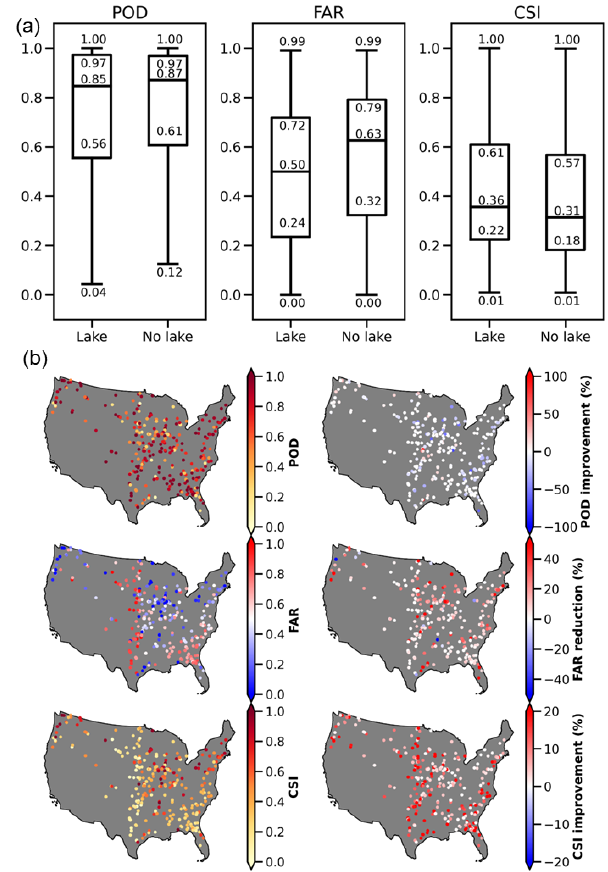
Figure 8. Flood detection performance comparing lake simulation and no lake simulation. (a) Similar to Fig. 5, but for flood detectabil- ity; (b) similar to Fig. 6, but for flood